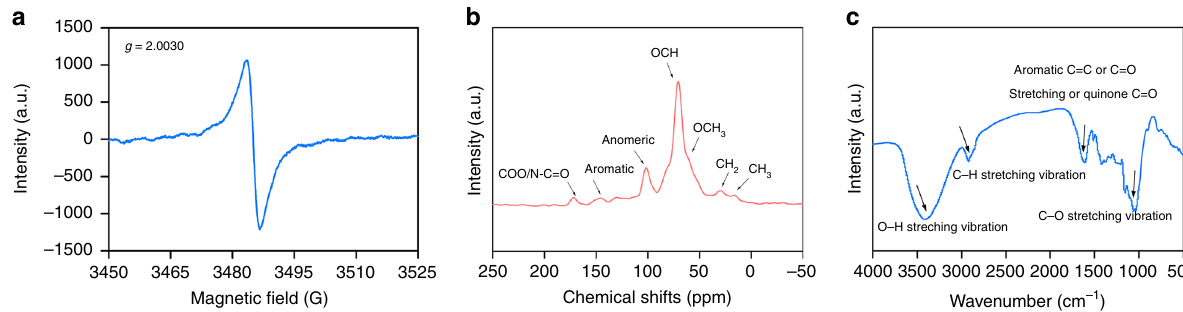
Fig. 5 Characteristics of particular organic matter. a EPR spectrum. b 13 C NMR spectrum. c FTIR